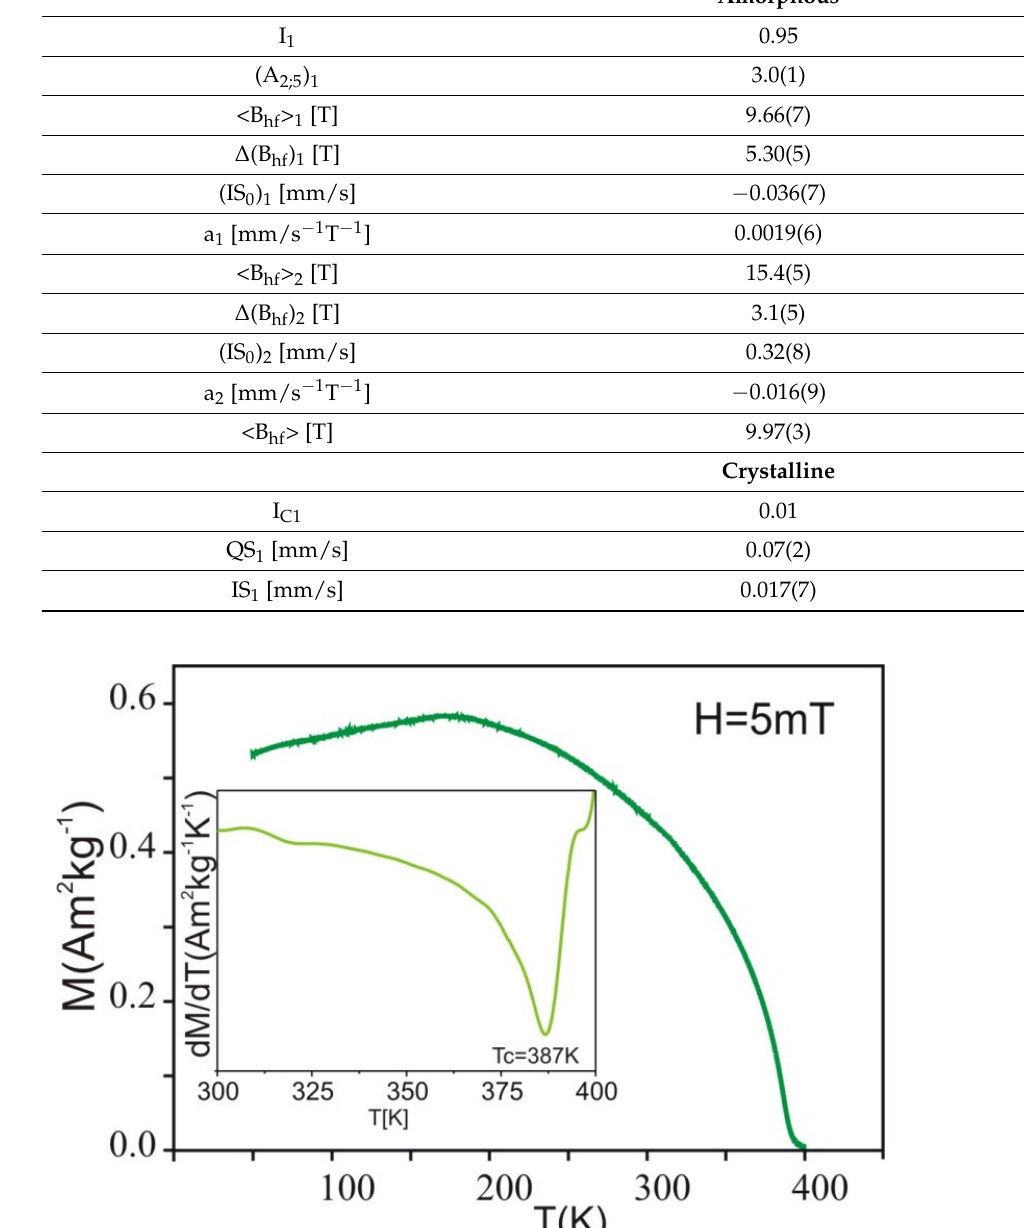
where T, μ 0 , H and M are mean temperature, magnetic permeability, magnetic field and magnetization, respectively. Taking into account that Equation (2) could be rewritten in as the following algo- rithm (3), which was implemented in Mathematica package [12]: max max 1 (3) where B is magnetic field induction, according to relation B = μ 0 H . Figure 5 depicts temperature dependence of magnetic entropy change. Broad maximum is typical for amorphous materials. The maximum value of the ΔS M equaled 0.76 J (kg K) −1 under the change of external magnetic field Δ(μ 0 H) = 1 T. This values is higher or comparable than those presented in [9,13,14]